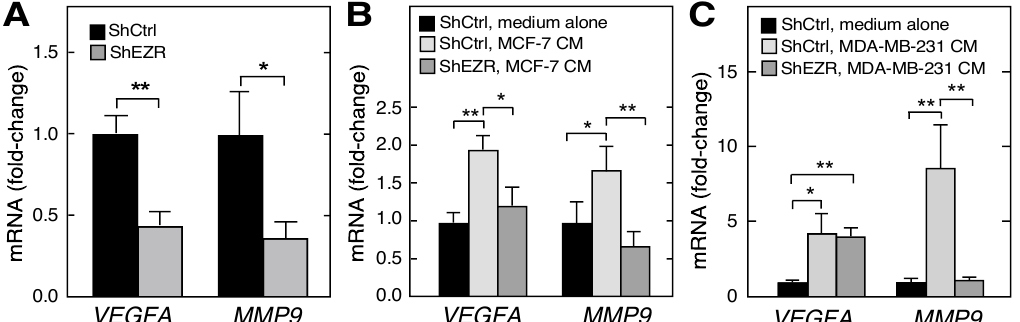
Figure 6. Role of ezrin in the myeloid cell expression of mRNAs encoding tumor growth stimulatory factors. ( A ) VEGFA and MMP9 mRNAs determined in the ShCtrl and ShEZR THP-1 cells by RT-qPCR. ( B , C ) ShCtrl and ShEZR THP-1 cells were incubated with CM from MCF-7 ( B ) or MDA-MB-231 ( C ) cells, or with medium alone, and VEGFA and MMP9 mRNAs determined by RT-qPCR; Mean ± standard deviation; * and ** indicate p < 0.05 and 0.01,